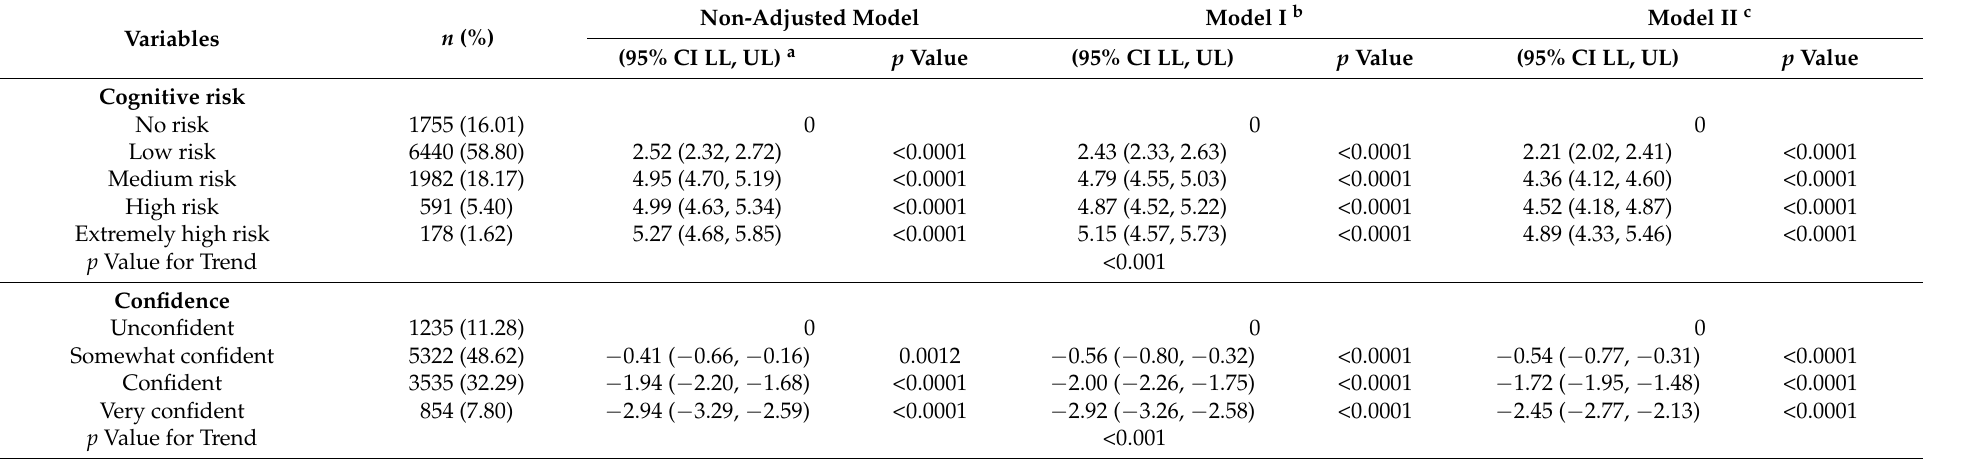
Table 3. The association of cognitive risk, confidence, and anxiety score in the whole